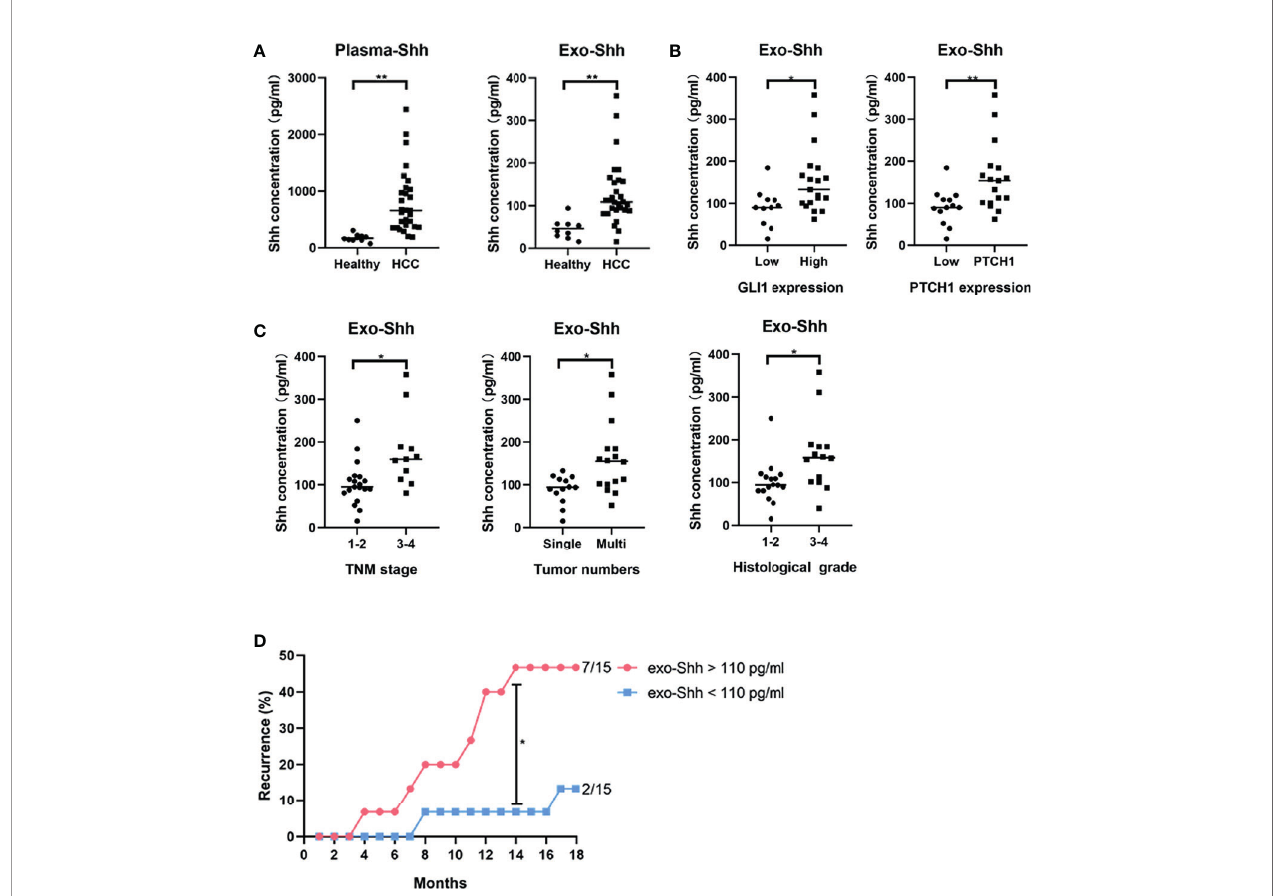
FIGURE 6 | (A) Levels of plasma Shh and Exo-Shh isolated from plasma from healthy donors and HCC patients as determined by ELISA. (B) Levels of Exo-Shh isolated from plasma of HCC patients grouped based on tissue GLI-1 and PTCH1 levels. (C) Levels of Exo-Shh isolated from plasma of HCC patients grouped based on cancer TNM stage, tumor numbers, and histological grade. (D) Recurrence of HCC after surgical sections grouped by the Exo-Shh levels. * p < 0.05, ** p <